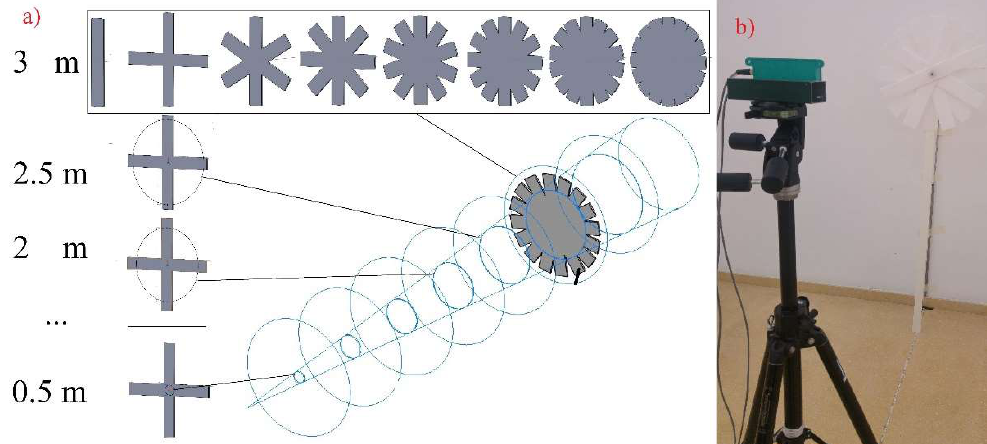
Figure 5. ( a ) Variable-density target for density’s influence on accuracy laboratory test, with the theoretical cone proposed by the manufacturer. ( b ) Laboratory layout.